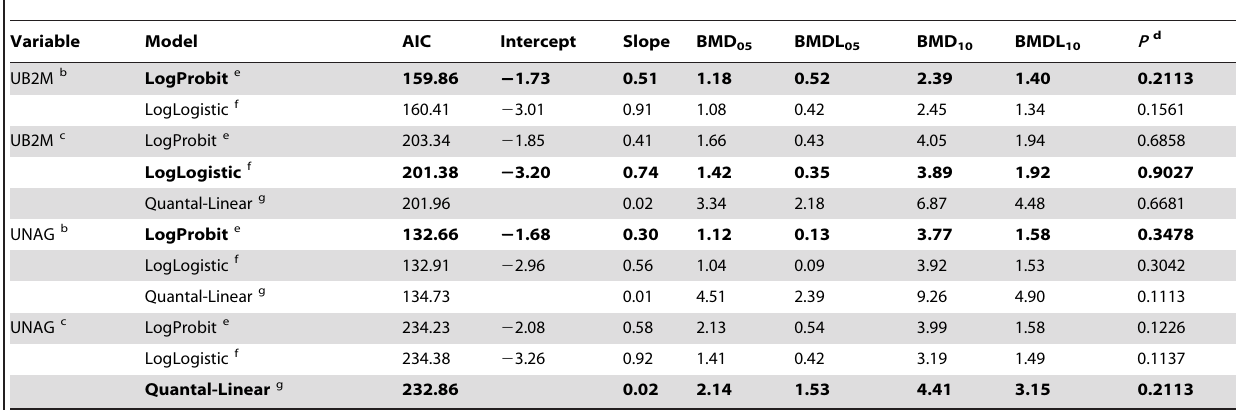
Table 5. Separate BMD estimates of UCd ( m g/g cr) based on UB2M ( m g/g cr) and UNAG (U/g cr) for subjects in CA and CB a .